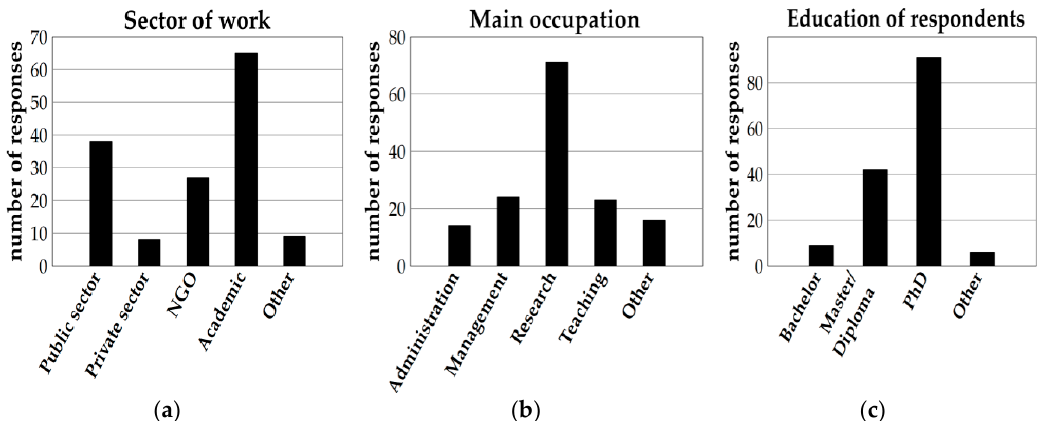
Figure 1. Sample composition—( a ) sector of work, ( b ) main occupation, and ( c ) level of education of survey respondents.NGO abbreviates Non-governmental organization.